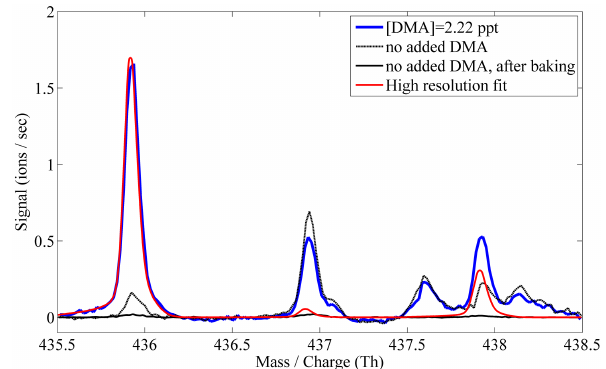
Figure 6. Response of bisulfate cluster signal to [DMA] = 0– 35pptV. DMA concentration in the CLOUD tank was adjusted by adjusting the DMA-containing flow to the